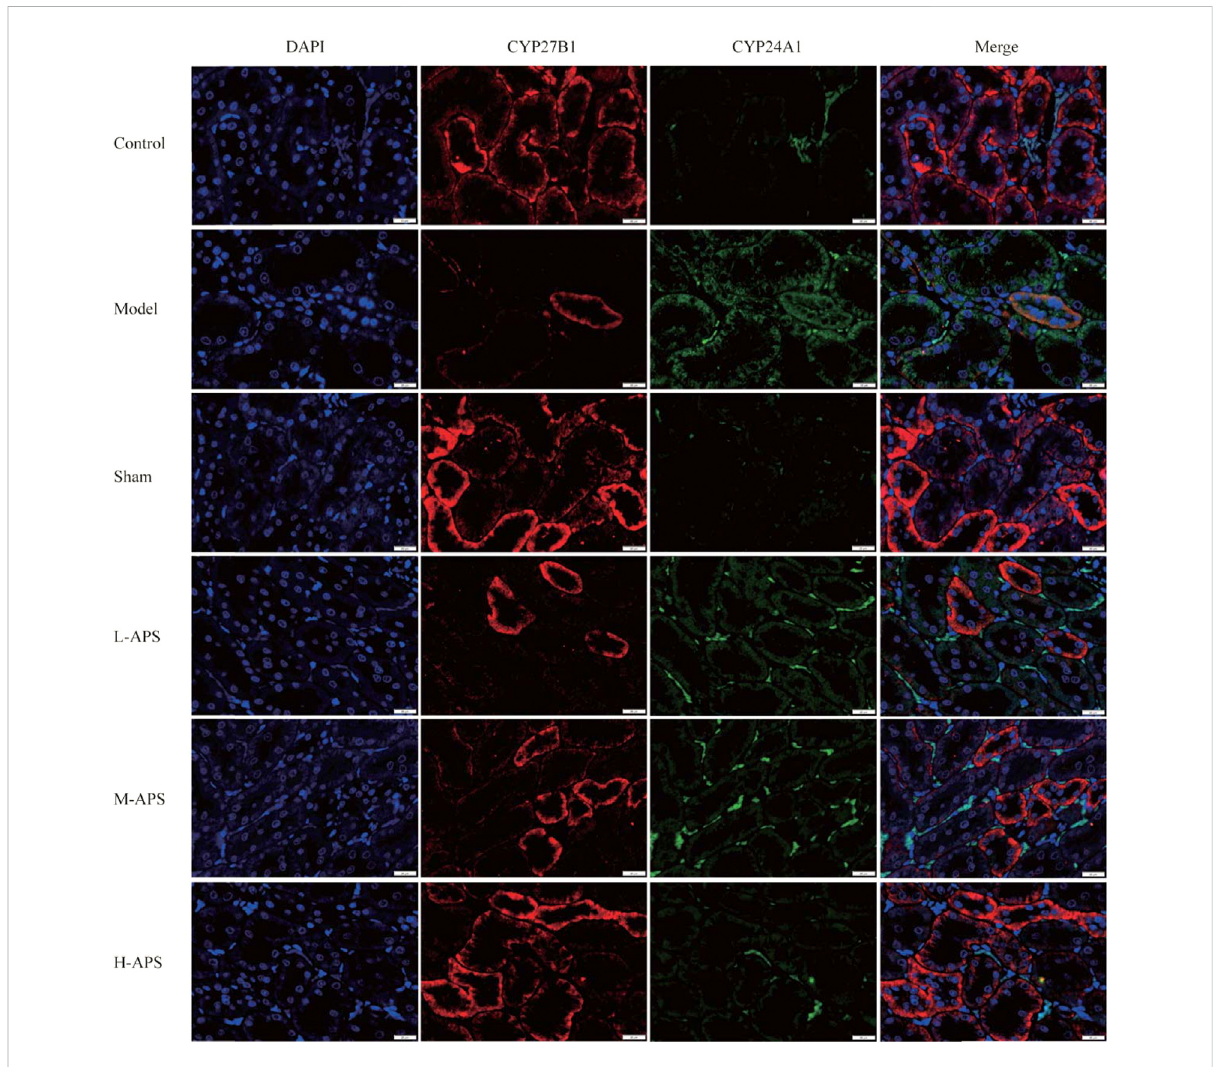
FIGURE 4 Immuno fl uorescence double staining detection of the protein expression of CYP27B1 and CYP24A1 in the rat kidneys. The scale bar is 20 μ